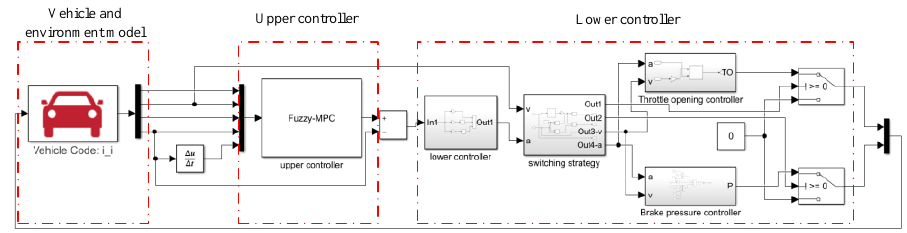
Figure 7. ACC system co-simulation environment establishment.